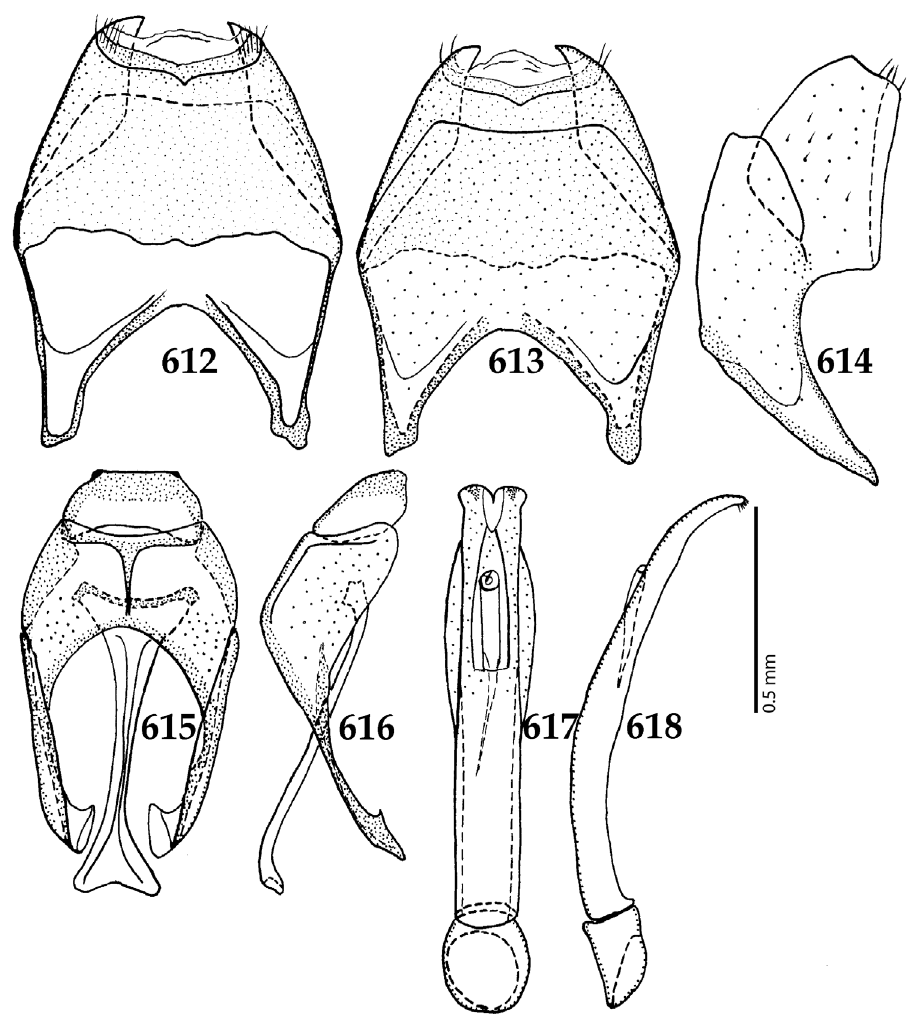
Figures 612–618. 612 Saprinus ( Saprinus ) viridipennis Lewis, 1901 male terminalia: 8 th sternite + 8 th tergite, ventral view 613 ditto, dorsal view 614 ditto, lateral view 615 male terminalia: 9 th + 10 th tergites, dorsal view; spiculum gastrale, ventral view 616 male terminalia: 9 th + 10 th tergites; spiculum gastrale, lateral view 617 male terminalia: aedeagus, dorsal view 618 ditto, lateral